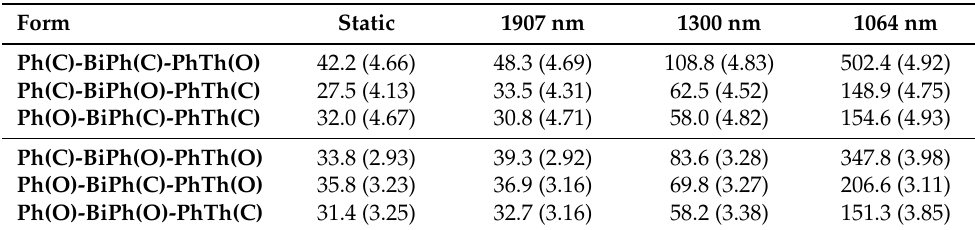
Table 3. Details of the static and dynamic first hyperpolarizabilities ( β HRS in 10 3 a.u., the DR in parentheses) of triBOX 3b in their different forms after one or two protonations (and BOX openings), as evaluated at the TDDFT/M06-2X/6-311+G(d)/IEF-PCM (acetonitrile) level of approximation. These are averaged values using the MB populations at 298.15K as calculated at the ω B97X-D/6- 311G(d)/IEF-PCM (acetonitrile) level of